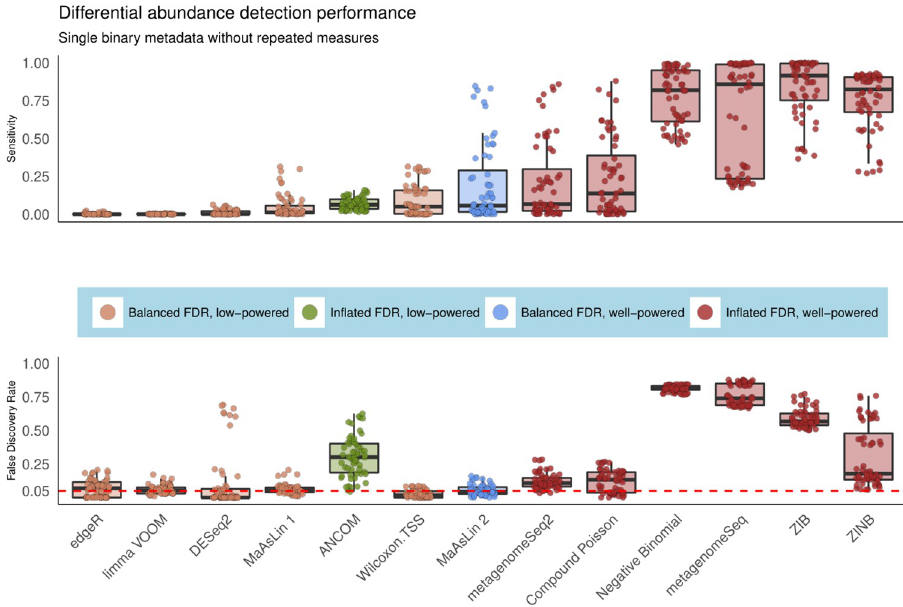
Fig 2. MaAsLin 2 controls false discovery rate while maintaining power in differential abundance analysis of microbial communities. To assess models’ behaviors during differential abundance analysis, we simulated 100 independent datasets per parameter combination, each containing a single binary metadatum and a fixed number of true positive features (10% of features differentially abundant) for varying association strengths and sample sizes ( S1A Fig ). We then evaluated the ability of different microbiome association methods to recover these associations using a variety of performance metrics and summarized the results across runs. Both sensitivity and false discovery rates (FDR) are shown for the best-performing method from each class of models (as measured by average F1 score). Compared to zero-inflated and count-based approaches, MaAsLin 2’s linear model formulation consistently controlled false discovery rate at the intended nominal level while maintaining moderate sensitivity (full results in S1–S8 Data ). Red line parallel to the x-axis is the target threshold for FDR in multiple testing. Methods are sorted by increasing order of average F1 score across all simulation parameters in this